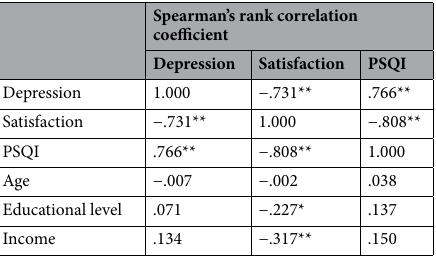
Table 5. Correlation matrix of elderly patients overall scores of depression, life satisfaction, and PSQI and their characteristics. (*)Statistically significant at p < 0.05, (**)statistically significant at p < 0.01.